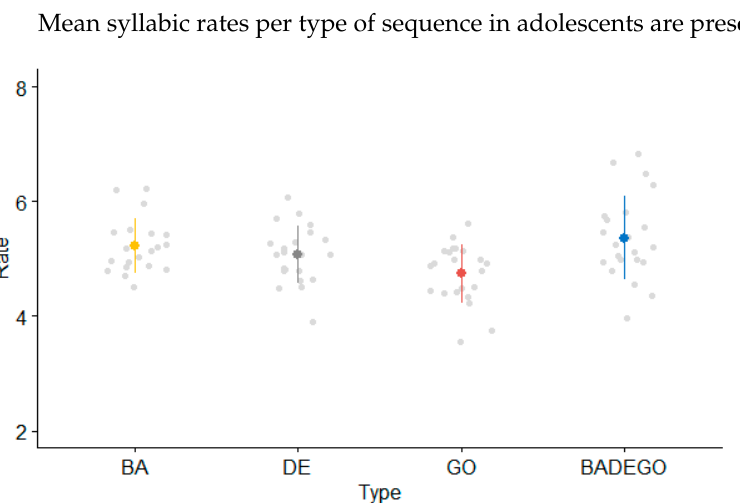
Figure 1. Adolescents’ mean syllabic rate (syllables per second) per type of sequence.